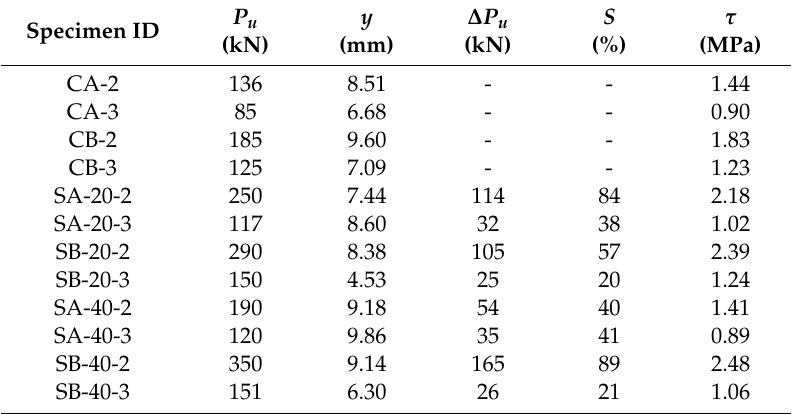
Table 3. Four-point bending experimental